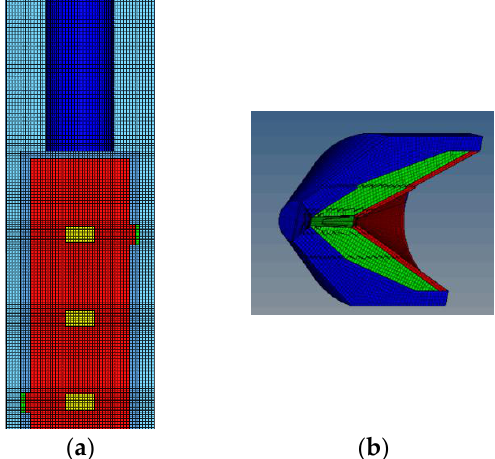
Figure 4. Meshing: ( a ) vertical section of mesh model; ( b ) mesh model of perforating bullet.